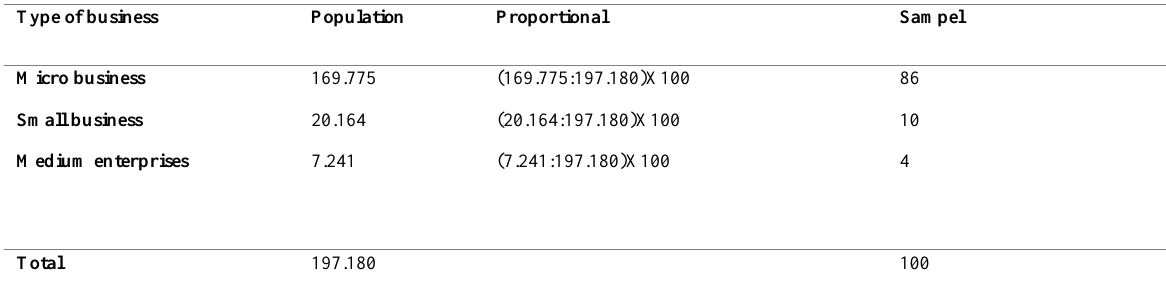
Tabel 1: Proportional to the distribution of the